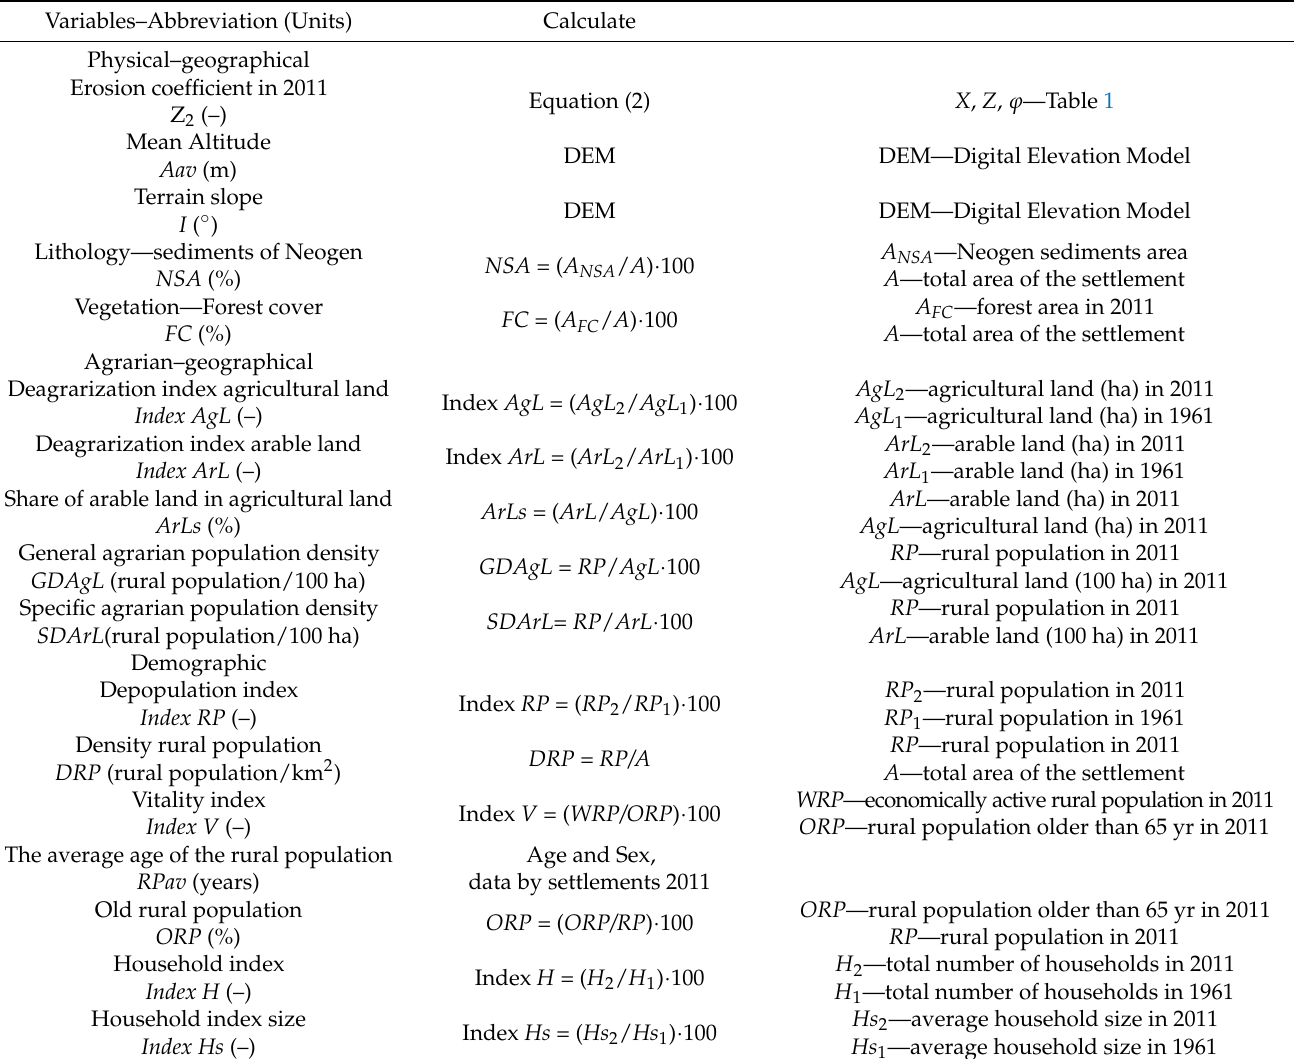
Table 3. Controlling variables used in the correlation analysis (CA) and principal component analysis